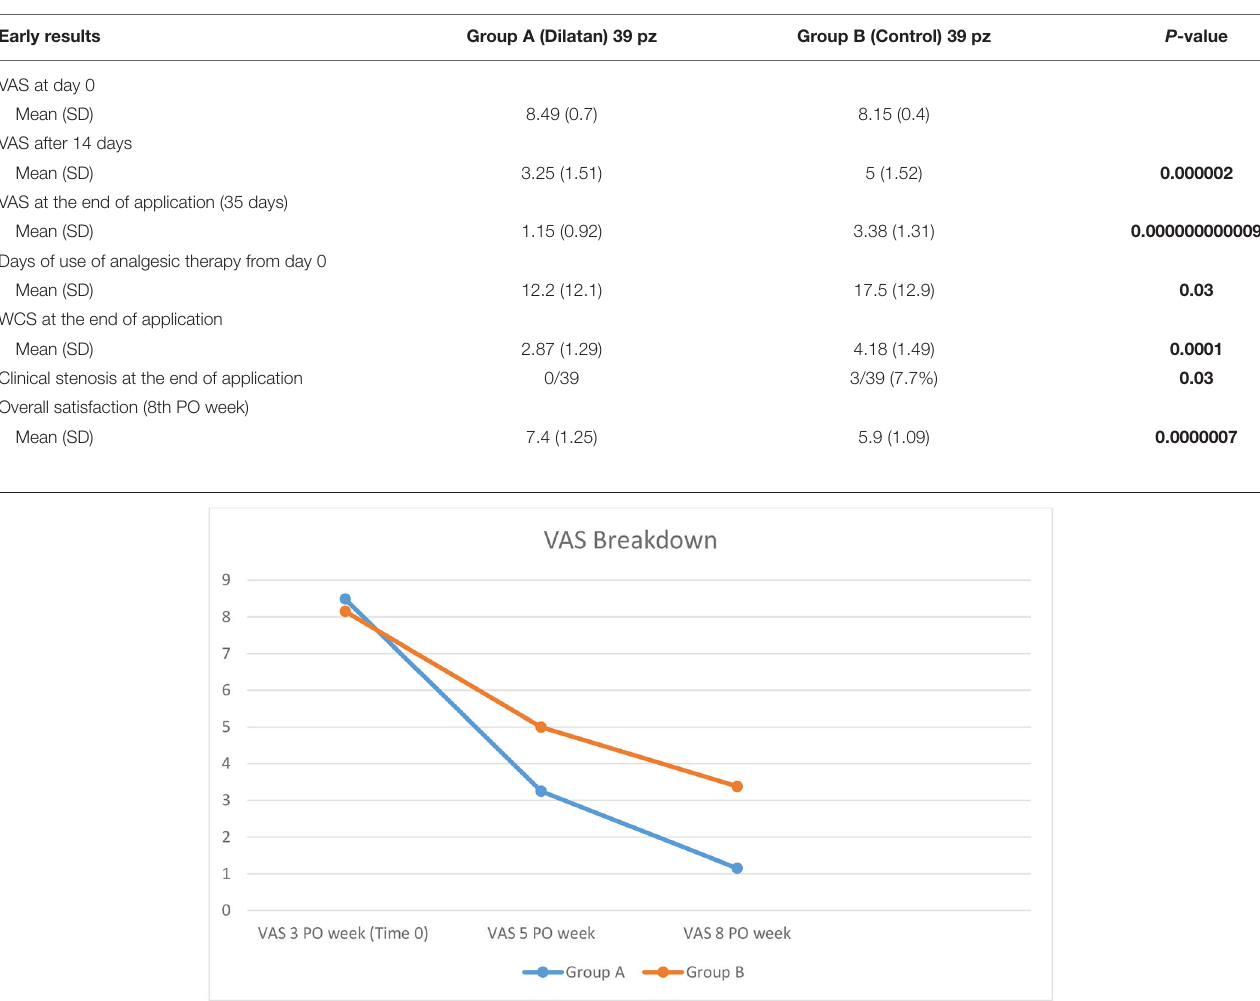
TABLE 2 | Early results in the two groups after the dilatation.